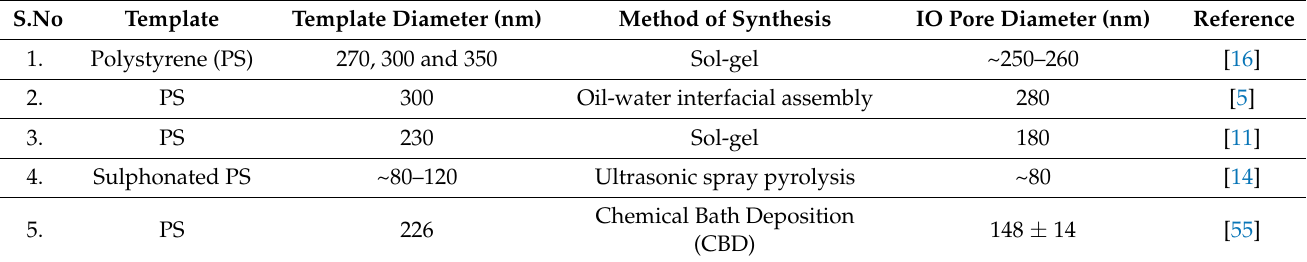
Table 1. A comparison of pore diameters of ZnO IOs fabricated using different